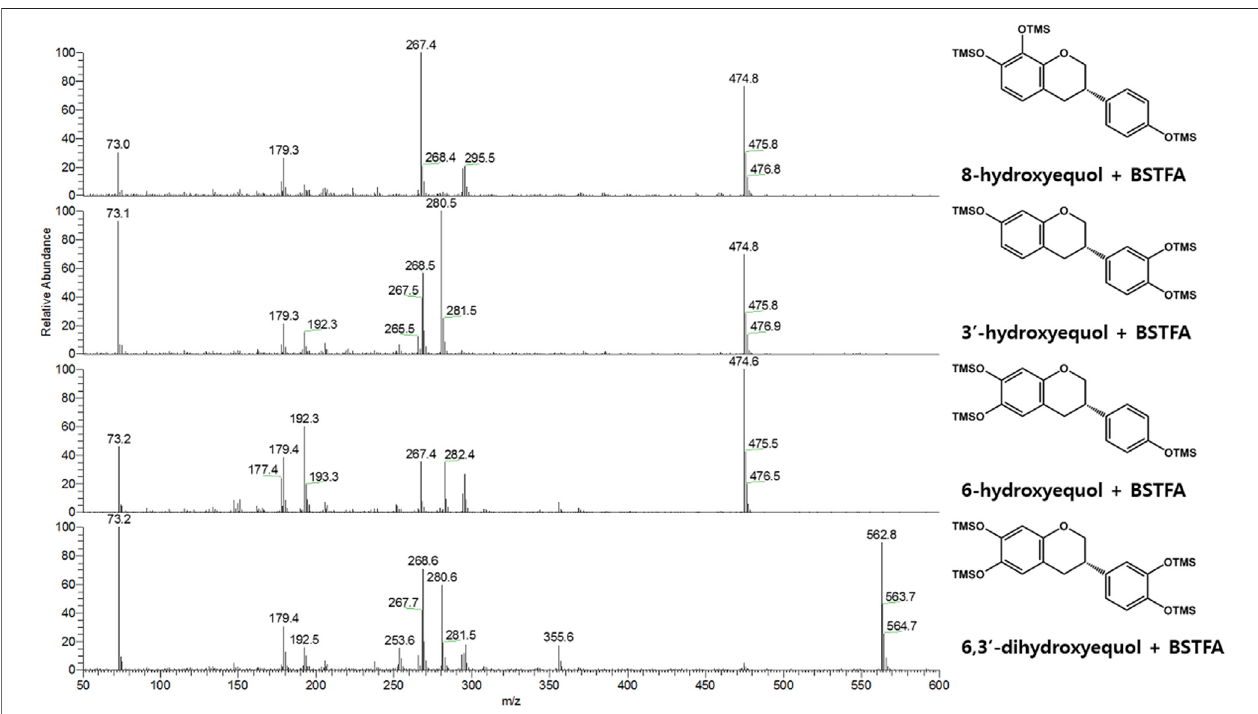
FIGURE 3 | EI-mass spectra (BSTFA: N, O-bis(trimethylsilyl)tri fl uoroacetamide) of trimethylsilylated hydroxy-( S )-equols biosynthesized by CYP0102G4 and Ec HpaBC. 3 ′ -hydroxyequol and 6-hydroxyequol were detected in both enzyme reaction samples, while 8-hydroxyequol and 6,3 ′ -dihydroxyequol were detected in the reaction extracts of CYP102G4 and Ec HpaBC, respectively.